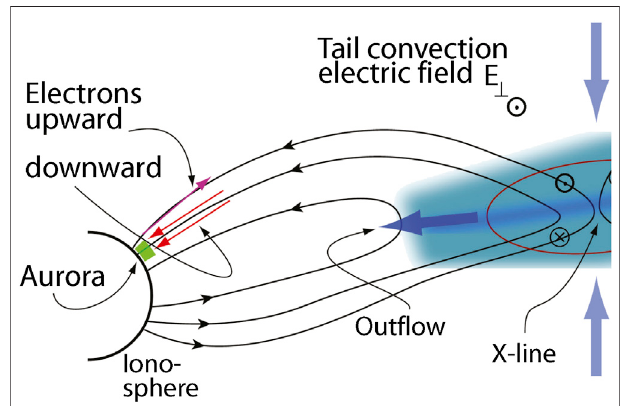
FIGURE 1 | Schematic of connection between tail reconnection and auroraltopsidecurrentsystemforonesingletailX-point(after[32]).Downward and upward fi eld-aligned electron fl uxes are indicated in the topside ionosphere. They correspond to upward and downward fi eld-aligned currents. Naturally, due tothe geometry of the tailward source, the downward fl uxes are distributed over a large spatial domain, while the returning upward fl uxes occupy a narrow latitudinal interval only on the northern